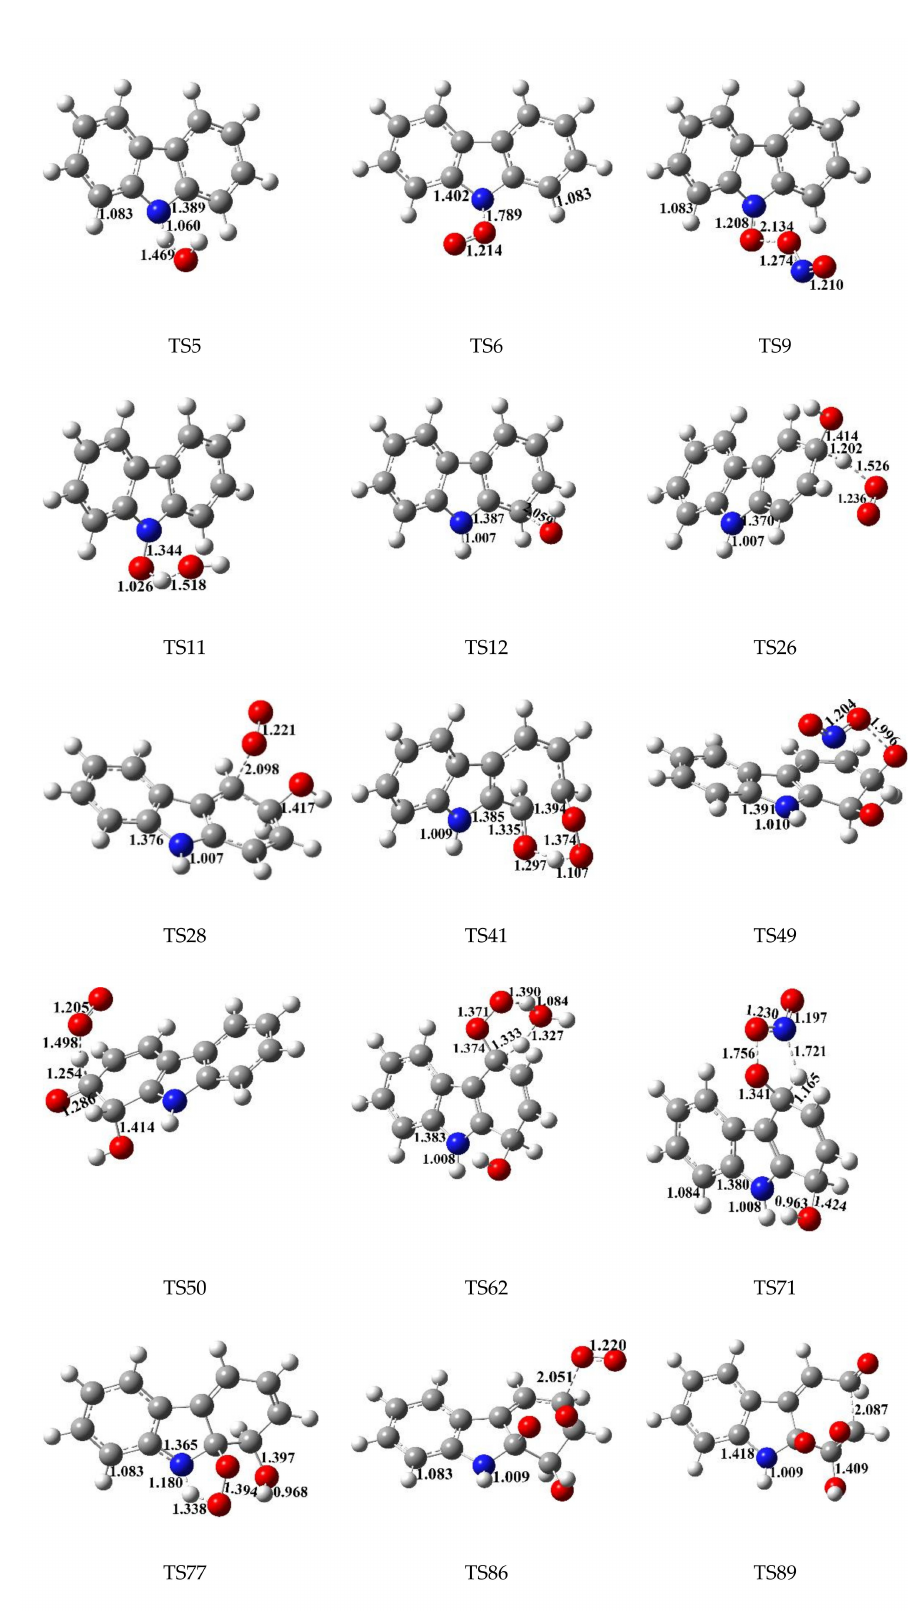
Figure 1. M06-2X/6-311+G(d,p) optimized geometries for typical transition states involved in the degradation of carbazole initiated by OH radical. Distances are in angstroms. Gray sphere, C; Blue sphere, N; Red sphere, O; White sphere,